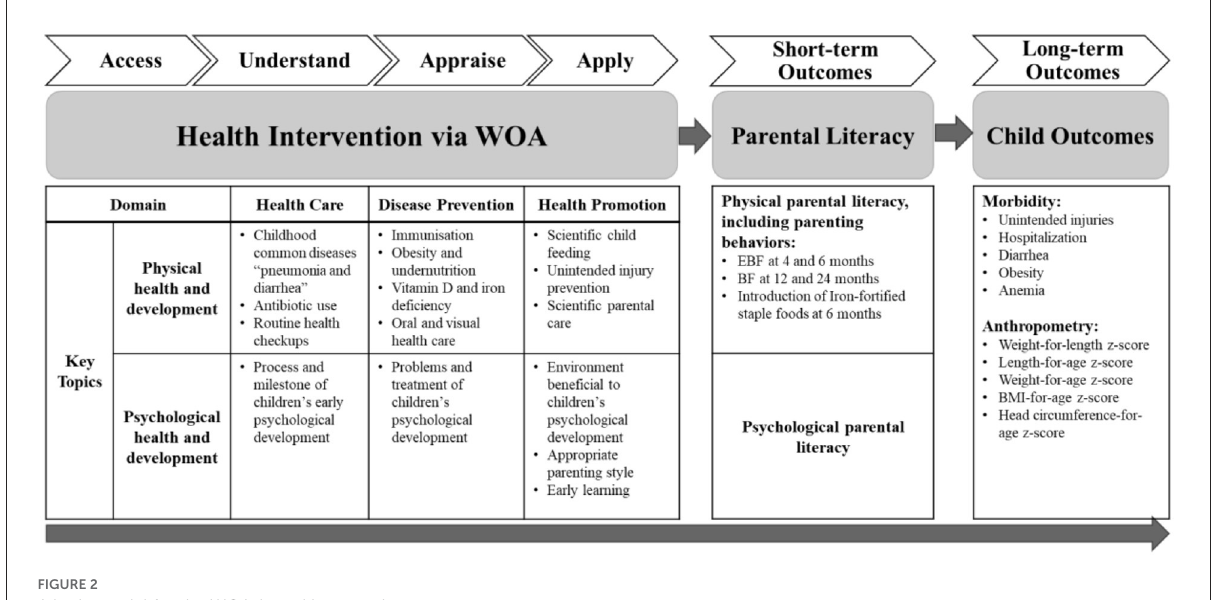
FIGURE2 A logic model for the WOA-based